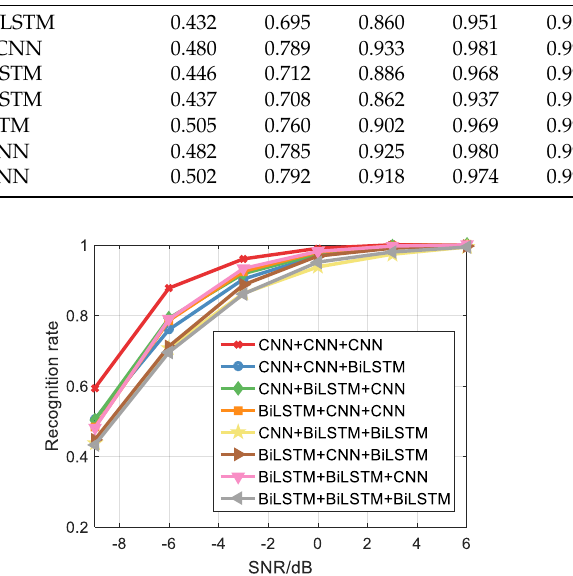
Table 5. The e ff ect of di ff erent feature extraction models on the recognition rate. Combination of Feature Extraction Models